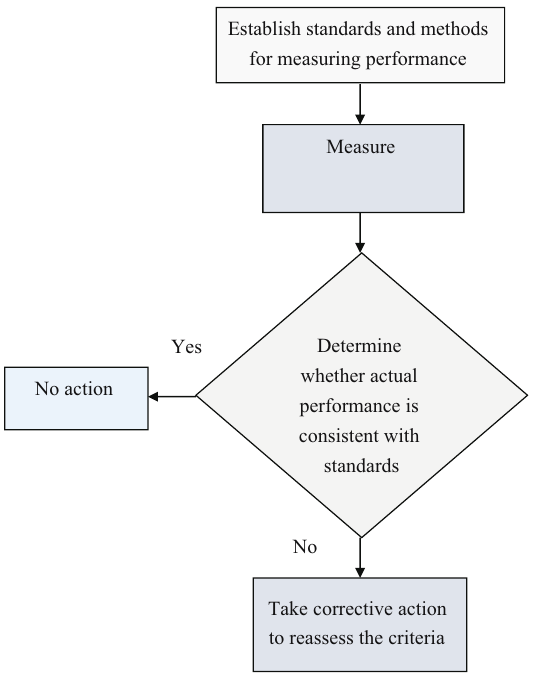
Figure 4: Controllable process of explicit channel. nodes are set: control target, standard, deviation information, and corrective measures, which form the key node of the whole control closed - loop.